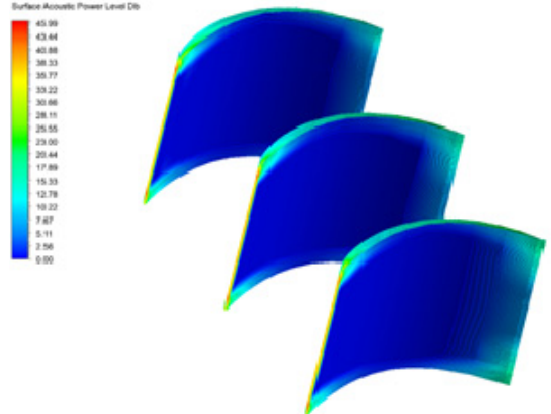
Figure 8. Surface acoustic power level on the airfoil